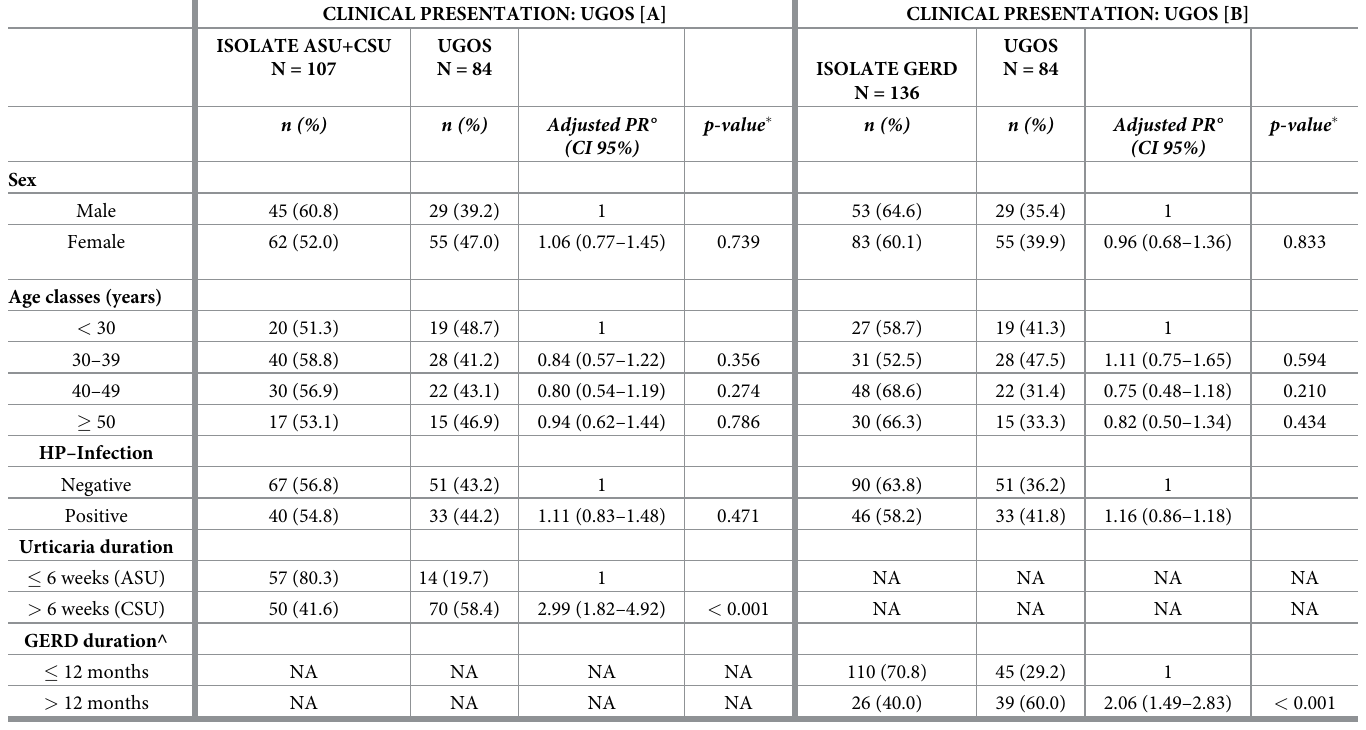
Table 5. Factors independently associated with urticaria and GERD overlap syndrome (UGOS) compared to patients suffering from isolated urticaria [A] or iso- lated gastroesophageal reflux disease (GERD)